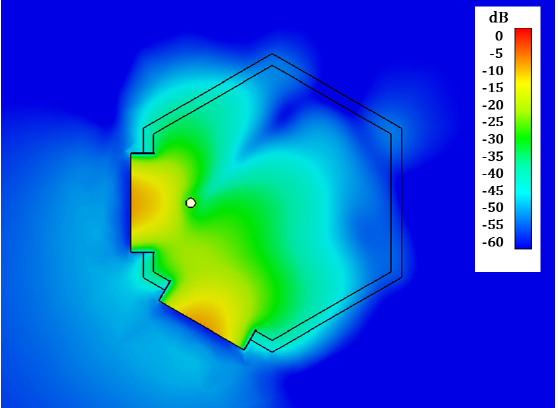
Figure 5. Simulated joint E-field distribution into the transverse plane of the horn antennas at 0.8 GHz. Frontal